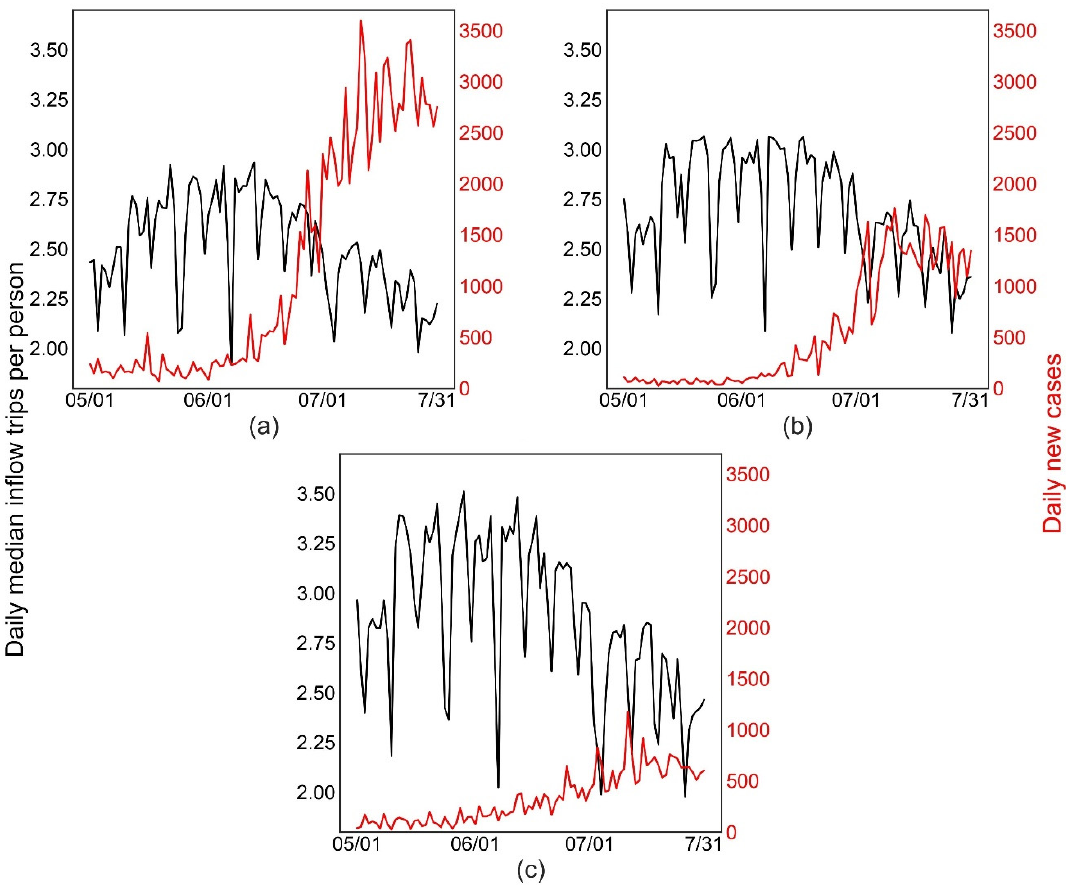
Figure 2. Median daily inflow trips per person and daily new COVID-19 cases (05/01–07/31/2020) for ( a ) Miami-Dade County, ( b ) Broward County, and ( c ) Palm Beach County.